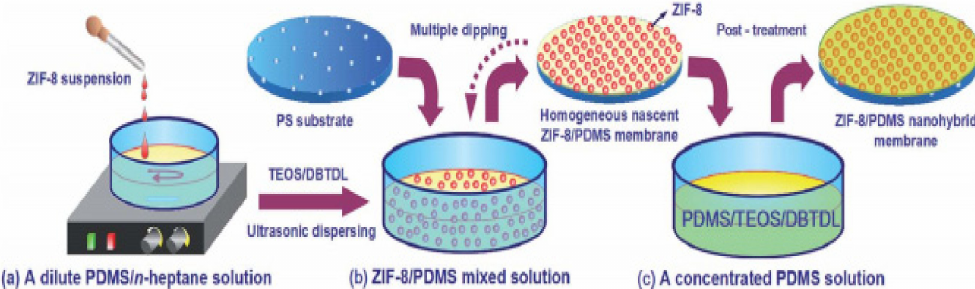
Figure 4. A novel synthesis method to avoid filler particle agglomeration [31]—(Republished with permission of Royal Society of Chemistry, from “Nanodisperse ZIF-8/PDMS hybrid membranes for biobutanol permselective pervaporation”, H. Fan, N. Wang, S. Ji, H. Yan, and G. Zhang, vol. 2, no. 48, Copyright (2021); permission conveyed through Copyright Clearance Center,